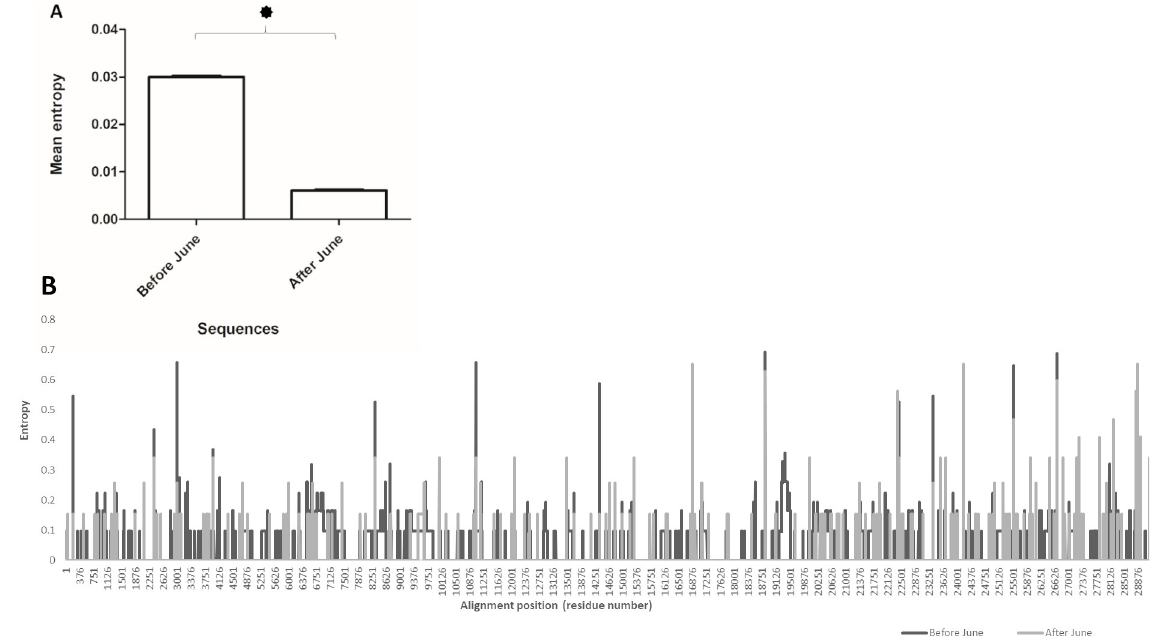
Fig 5. Genome-wide site-by-site entropy analysis for SARS-CoV-2 sequences from before and after June, 2020. The figure shows A) Mean entropy and B) site-by-site entropy for sequences collected before and after June 2020. ‘ � ’ in 4A indicates statistically significant (p < 0.001) difference between the means. Error bars shown standard error of